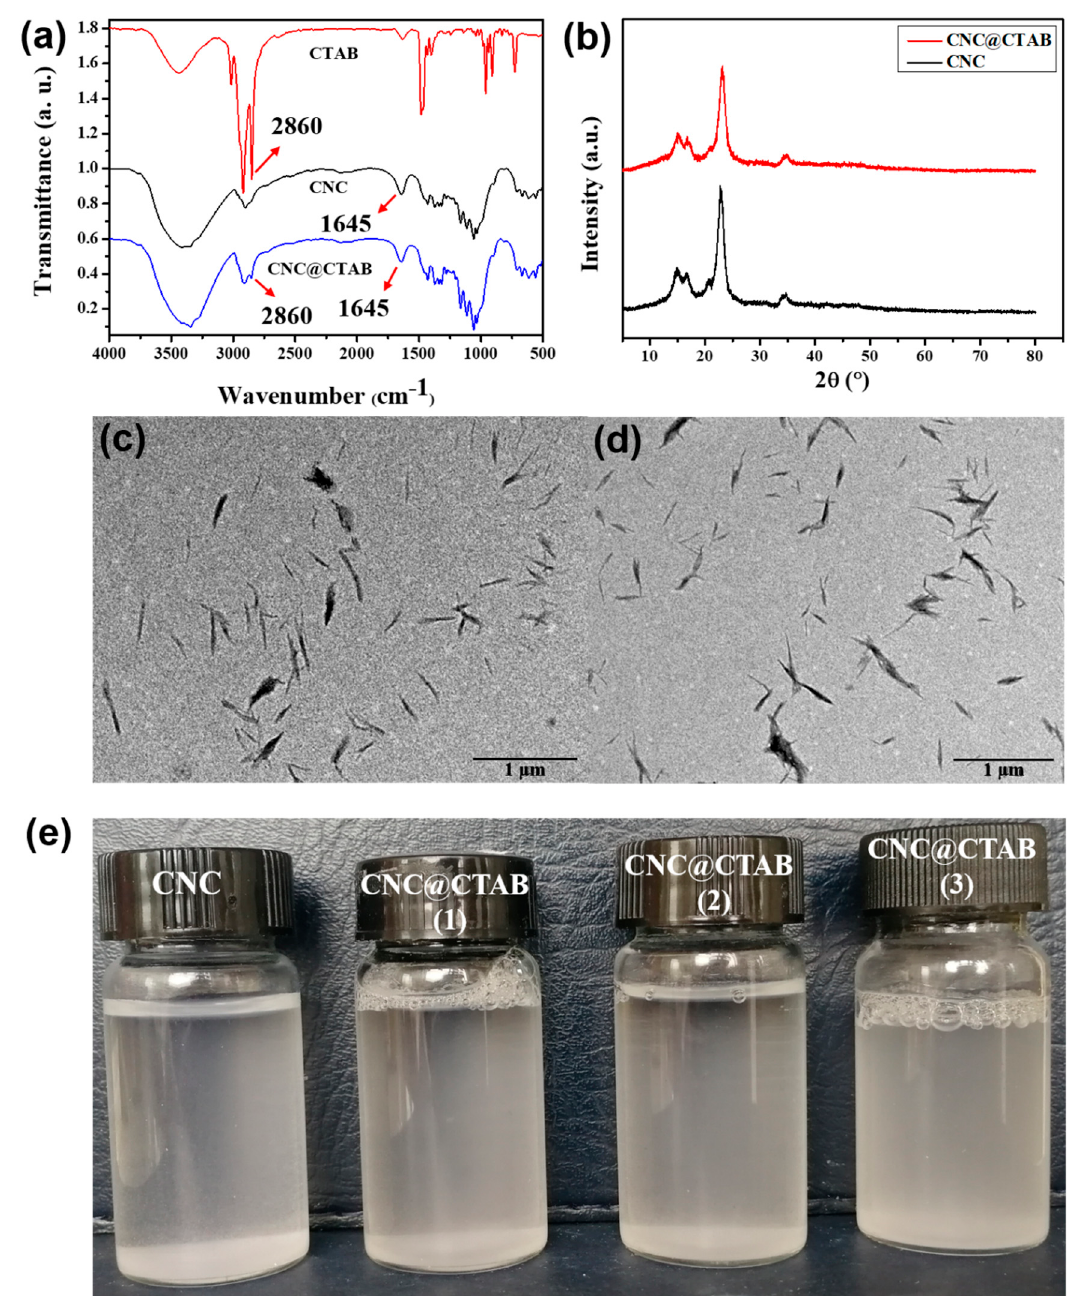
Figure 1. The Fourier transform infrared (FTIR) spectroscopy of the cellulose nanocrystal (CNC) and CNC@ coating hexadecyl trimethyl ammonium bromide (CTAB) ( a ). The X-ray diffraction patterns obtained for the CNC and CNC@CTAB ( b ). The transmission electron microscope (TEM) images for